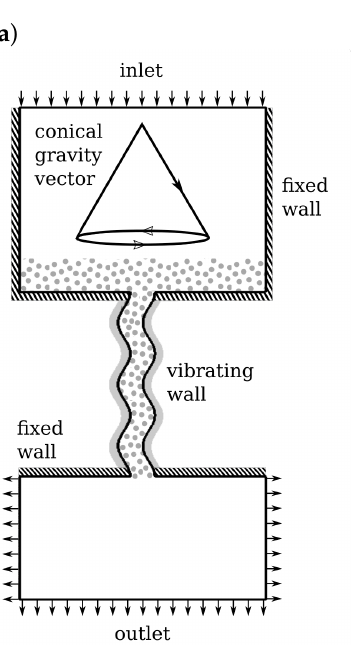
Figure 7. Morimoto geometry and boundary conditions. ( a ) A schematic in 2D showing the boundary conditions and gravity vector; ( b ) half the domain in 3D to further aid understanding. The section in red is set as a vibrating wall.